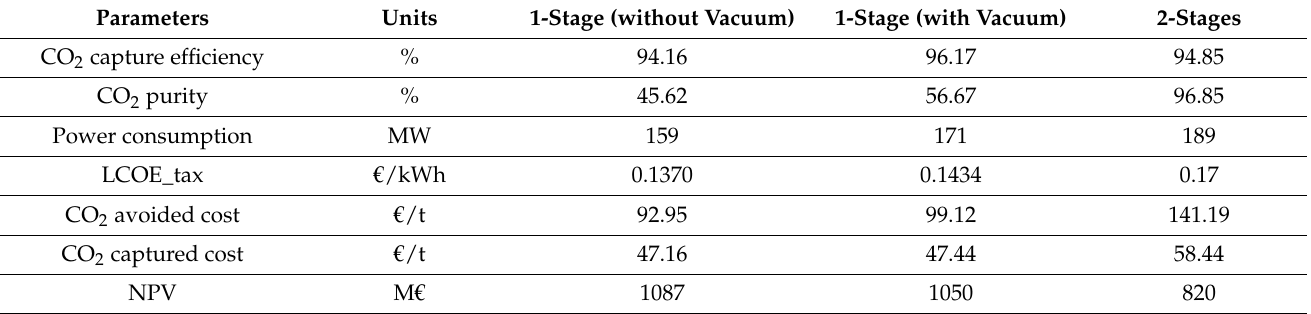
Table 18. A comparison 1- and 2-stages of membrane regarding different